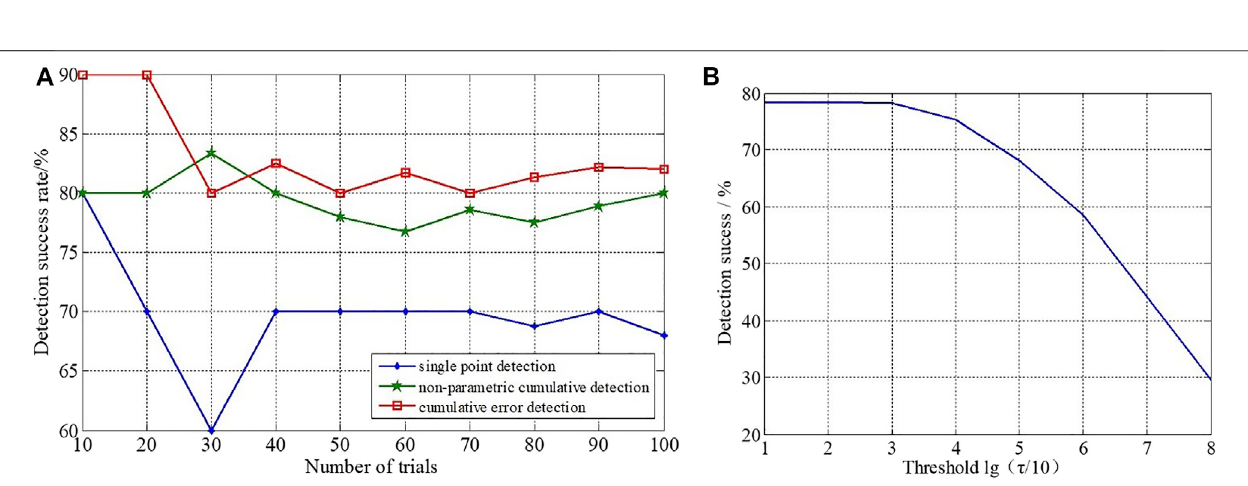
Frontiers in Energy Research |